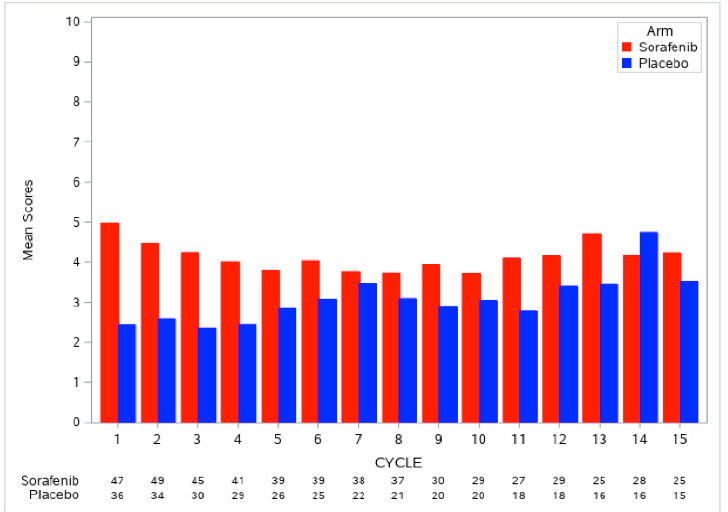
Figure 2. AE burden by treatment cycle, B(t) , grouped by treatment arm for A091105.